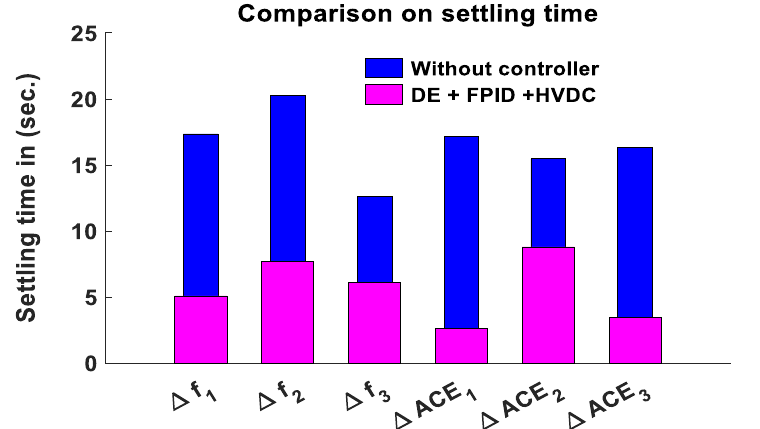
Figure 16. Comparison of controller and without controller for settling time for frequency deviation and area control error.